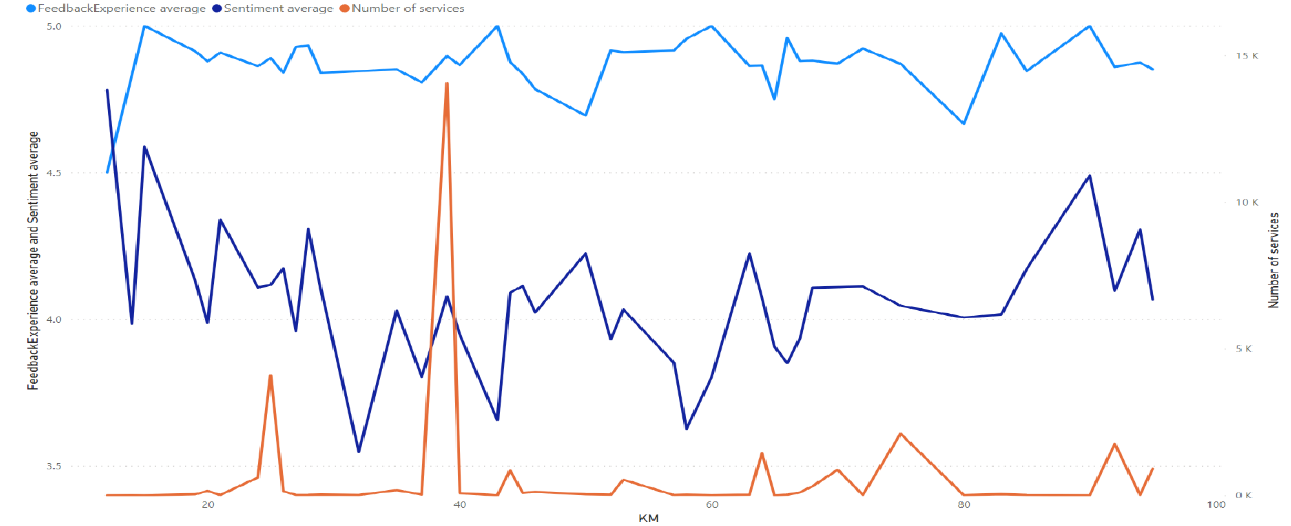
Figure 8. The normalised sentiment expressed in reviews, experience feedback, and the number of km per trip for services with at most 100 kilometres.